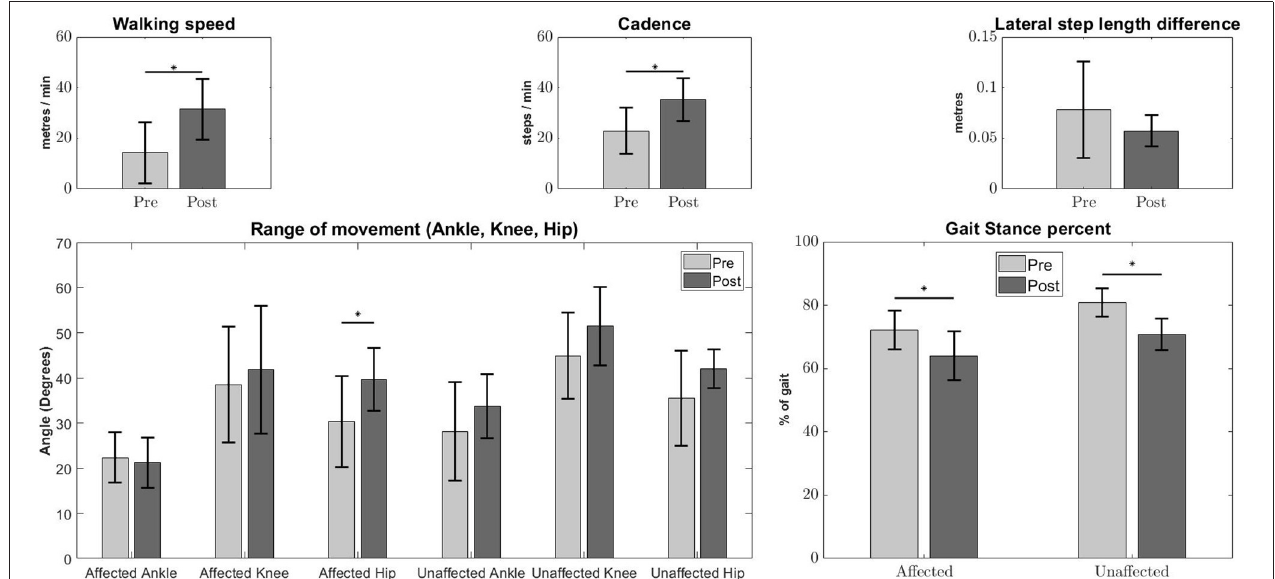
FIGURE 1 | Kinematic measures Pre-Post conditions. Error bars denote the standard deviation. Improvements were observed in walking speed (Top Left) , step cadence (Top Middle) , stance duration percentage of affected and unaffected side (Bottom Right) , and Pre-Post affected hip angles (Bottom Left) . The Lateral step length difference (Top Right) and other joint angles (Bottom Left) do not show any significant differences. The asterisks indicate statistical significance.